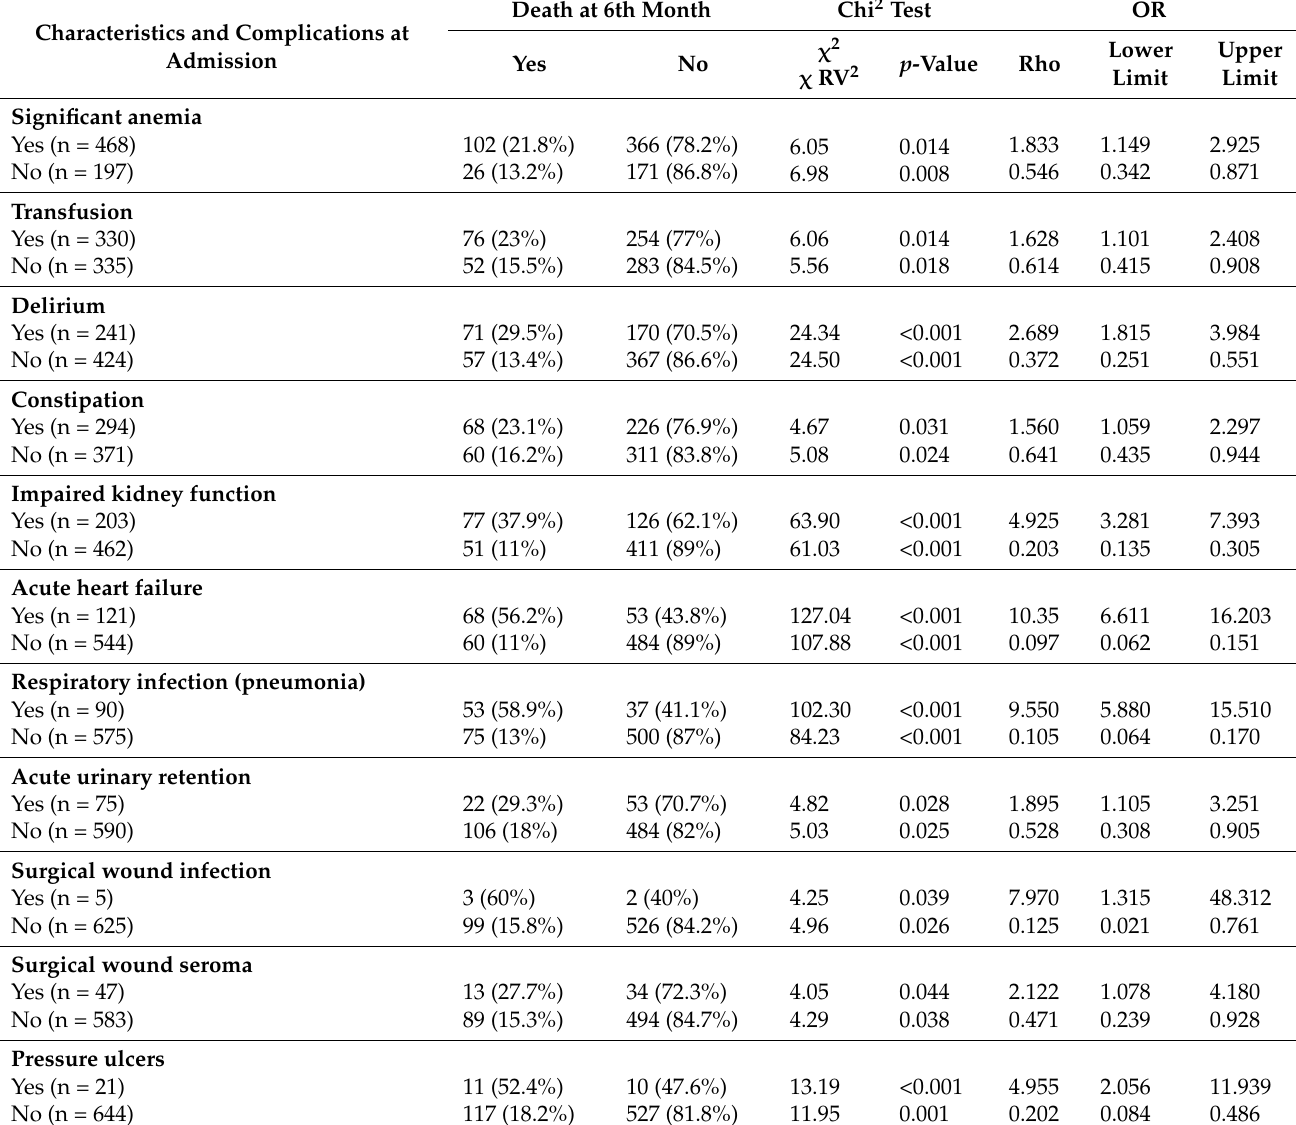
Table 3. Results of the Chi 2 test between mortality at the sixth month and characteristics and complications at